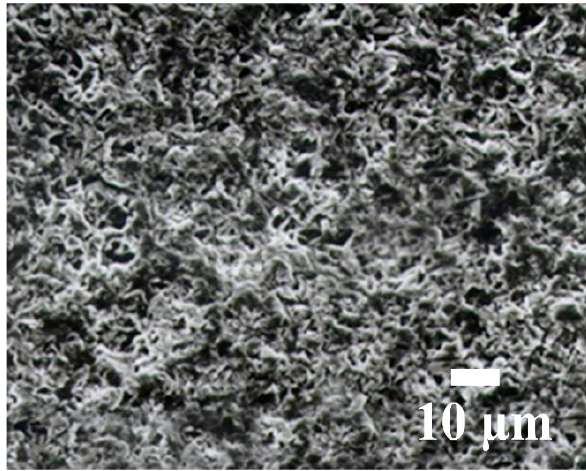
Figure 11. Machined surface using swinging WSM and a slurry of green silicon carbide (GC).